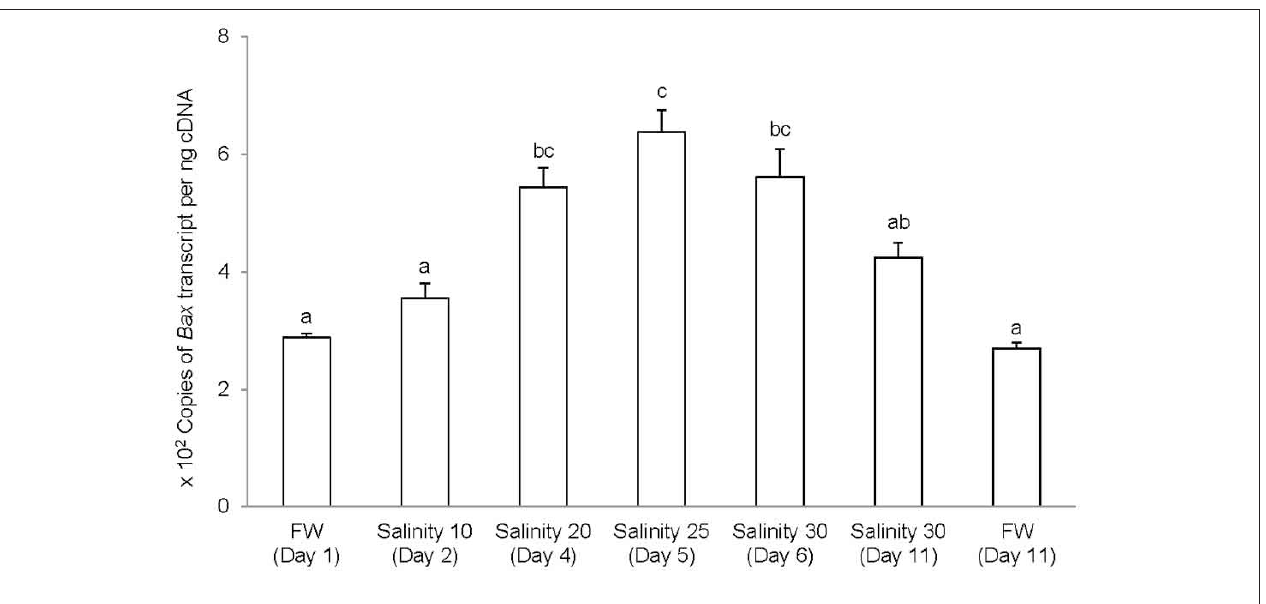
FIGURE 7 | Absolute quantification of Bcl-2 associated X protein ( bax ) mRNA (copies of transcript per ng cDNA) in the gills of Anabas testudineus kept in freshwater (FW) for 1 or 11 days (controls), or exposed to a 5-day progressive increase in salinity (S) from FW (day 1)